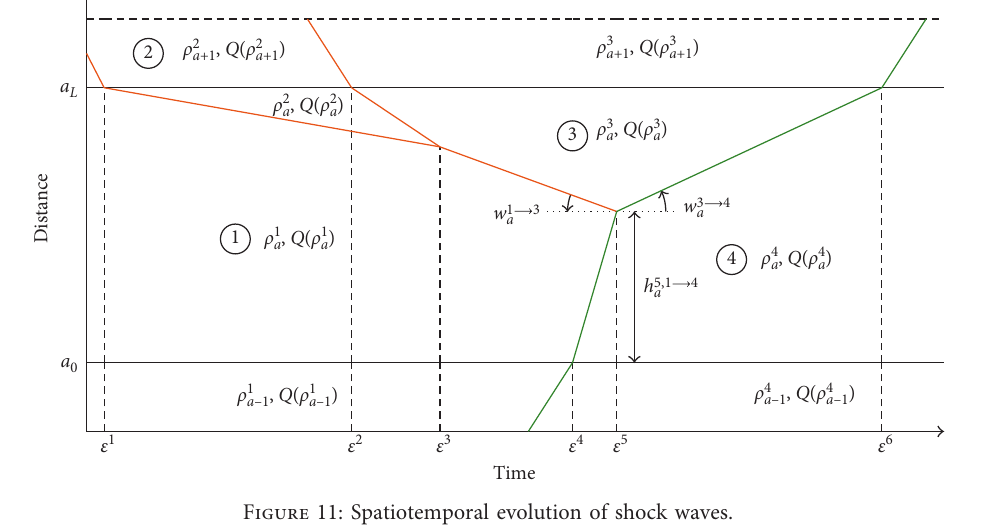
Figure 11: Spatiotemporal evolution of shock waves.